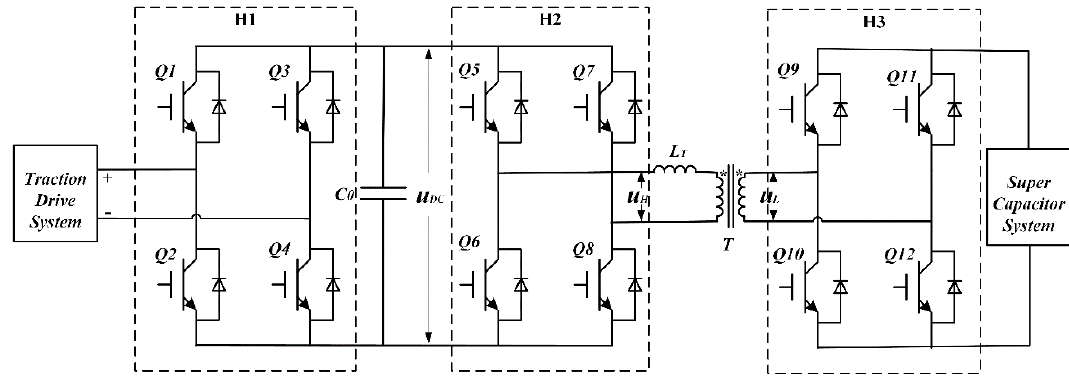
Figure 6. The schematic circuit of the PWM bidirectional converter.